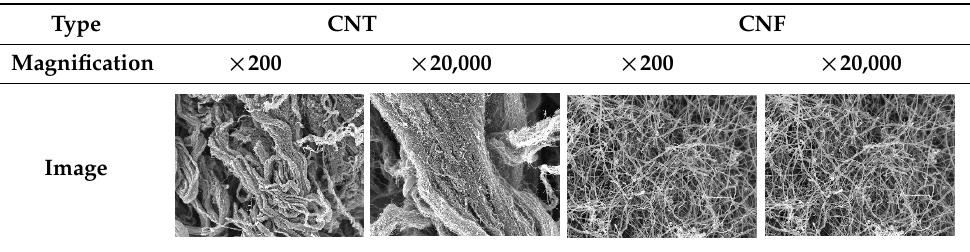
Table 4. Morphology of the types of carbon nanomaterials.